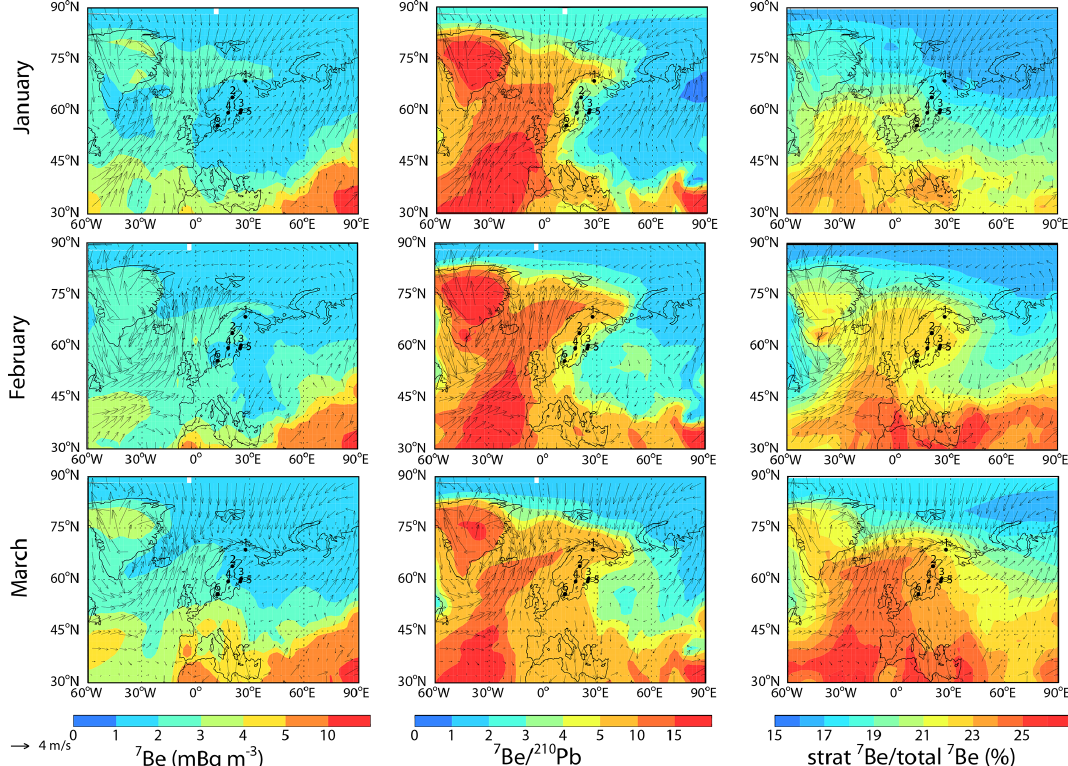
Figure 3. Simulated monthly mean 7 Be surface concentrations (mBqm − 3 ), 7 Be / 210 Pb ratio and fraction of stratospheric 7 Be for January– March 2003. Arrows represent winds in the MERRA-2 reanalysis. The dots indicate the locations of the sampling sites: 1 = Ivalo, 2 = Umeå, 3 = Helsinki, 4 = Kista, 5 = Harku, 6 = Risø.